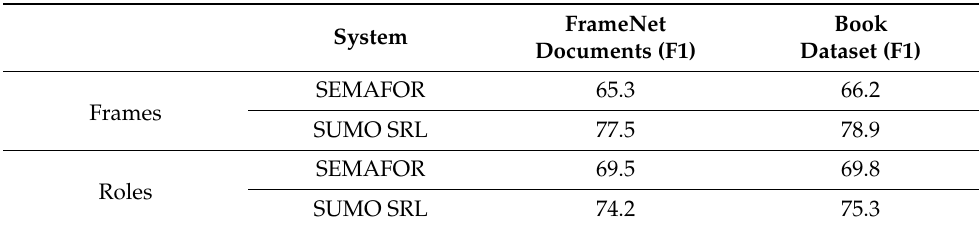
Table 6. FrameNet shallow semantic parsing of sentences from the book corpus and a set of sentences from the FrameNet corpus.